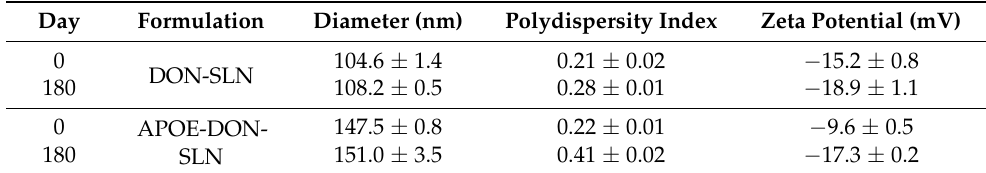
Table 1. Particle size, polydispersity index, and zeta potential values of non-targeted (DON-SLN) and ApoE- targeted SLNs (APOE-DON-SLN) determined at the day of preparation and at the end of a six-month period. Values presented are means ± SD ( n = 3).